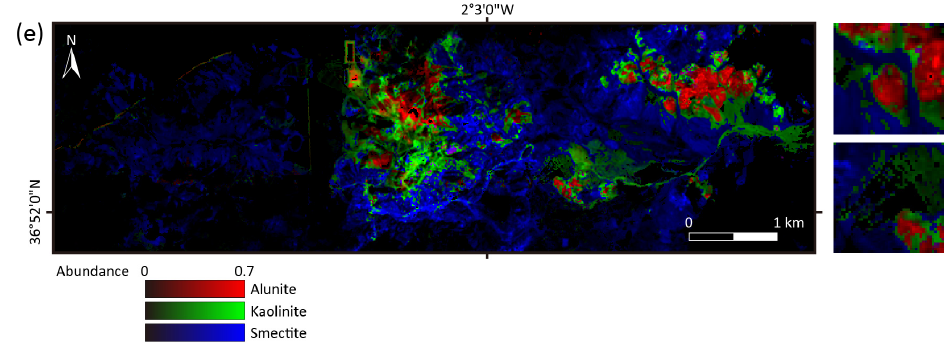
Figure 8. Color composite images of abundance fractions obtained from ( a ) nearest-neighbor interpolation; ( b ) bicubic interpolation; ( c ) GSA; ( d ) CNMF; and ( e ) reference images by MESMA for alunite ( red ); kaolinite ( green ); and smectite ( blue ). Abundance fractions are linearly stretched between 0 to 0.7 for better visualization.